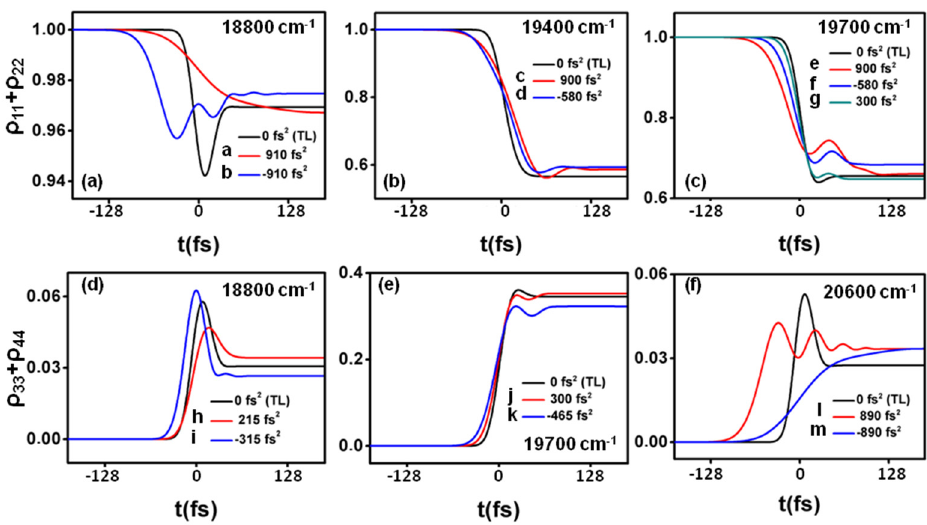
Figure 3. Time evolution of the populations in the ground state ( a – c ); and in the upper states ( d – f ); for specific parameter values, as indicated. Note that the lines, which are named with letters, correspond to the parameter values detailed in Figure 5a,e.